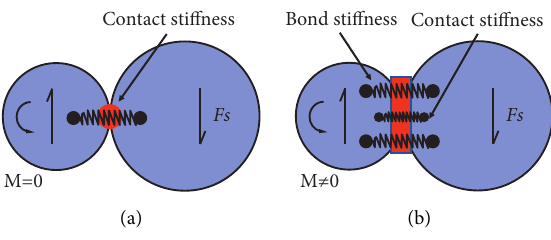
Figure 1: Bond models of PFC